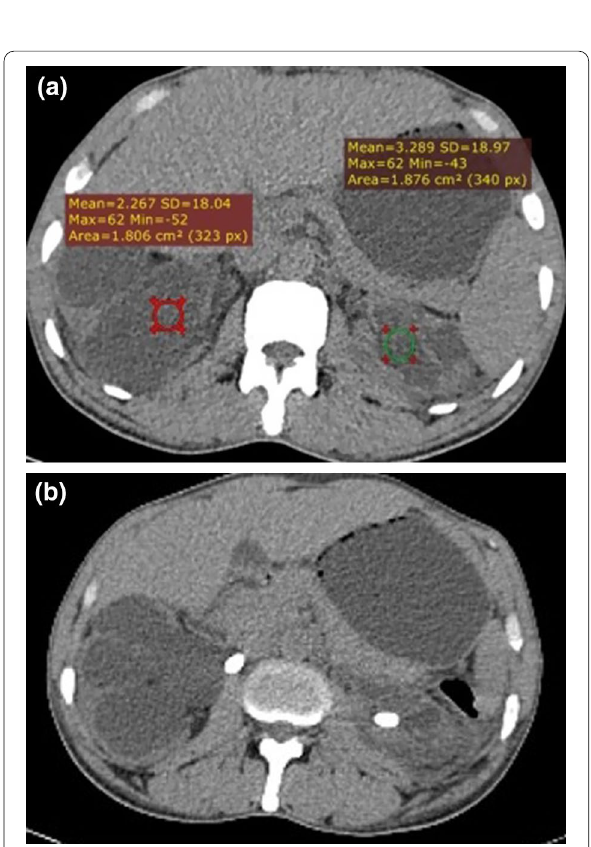
Fig. 4 a CT scan showing markedly dilated both pelvicalyceal system and ureters with thinning out of the renal parenchyma. Mean HU within the dilated right pelvicalyceal system 2.2 indicating = the diagnosis of hydronephrosis. Mean HU within the dilated left pelvicalyceal system 3.2 indicating the diagnosis of hydronephrosis. = b Axial CT scan of the same patient showing bilateral pelvic renal stones